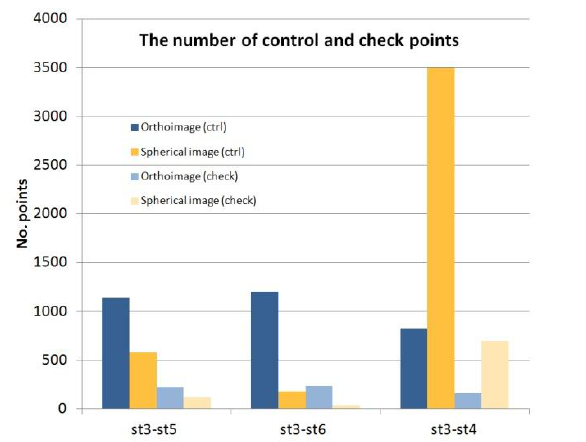
Figure 4: The numbers of control and check points detected in spherical images and orthoimages (Test site